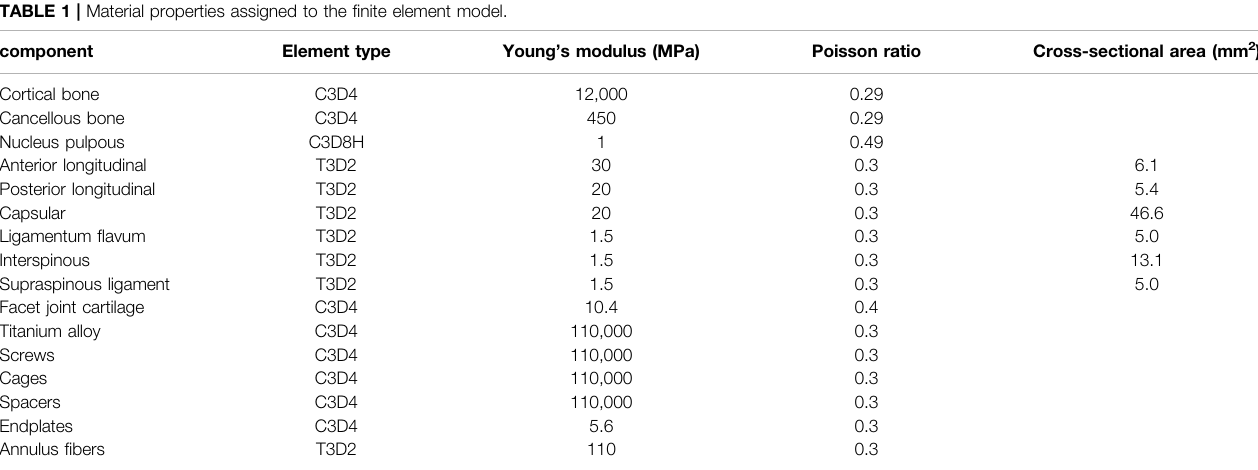
TABLE 1 | Material properties assigned to the fi nite element model.